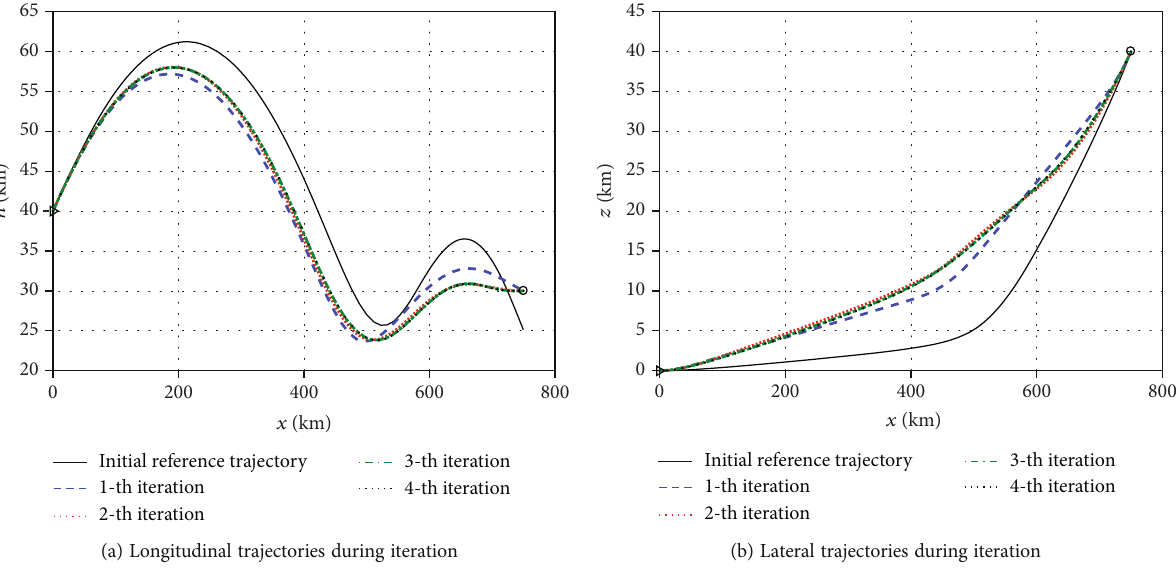
Figure 4: Trajectories during